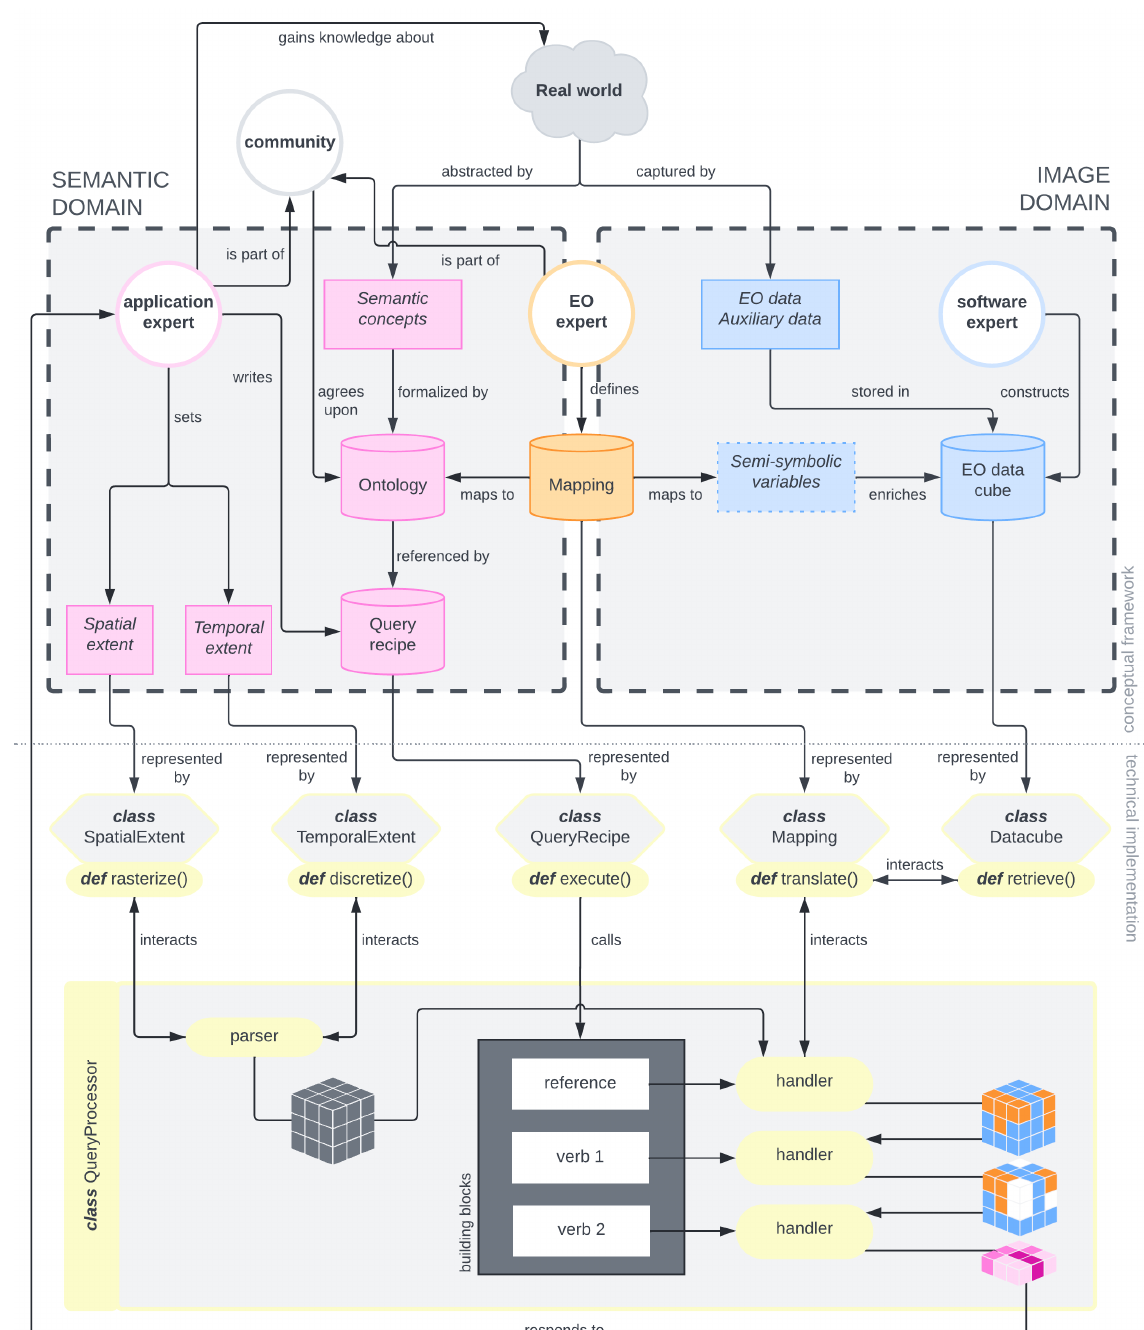
Figure 1. Graphical summary of the conceptual framework and its technical